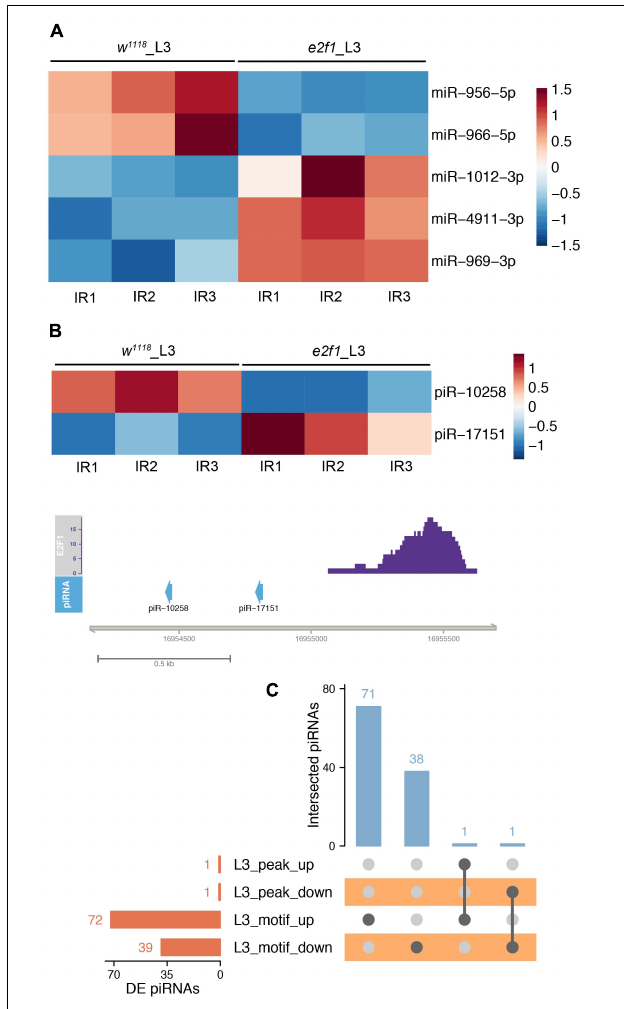
FIGURE 9 | E2f1 regulated small ncRNAs in response to X-ray irradiation. (A) Heatmap of DE miRNAs in e2f1 mutant L3 containing E2f1 binding-motif. (B) Illustration of DE piRNAs in e2f1 mutant L3 containing E2f1 binding-peak. (C) UpSet plot depicting the number of DE piRNAs with E2f1 binding-peak and E2f1